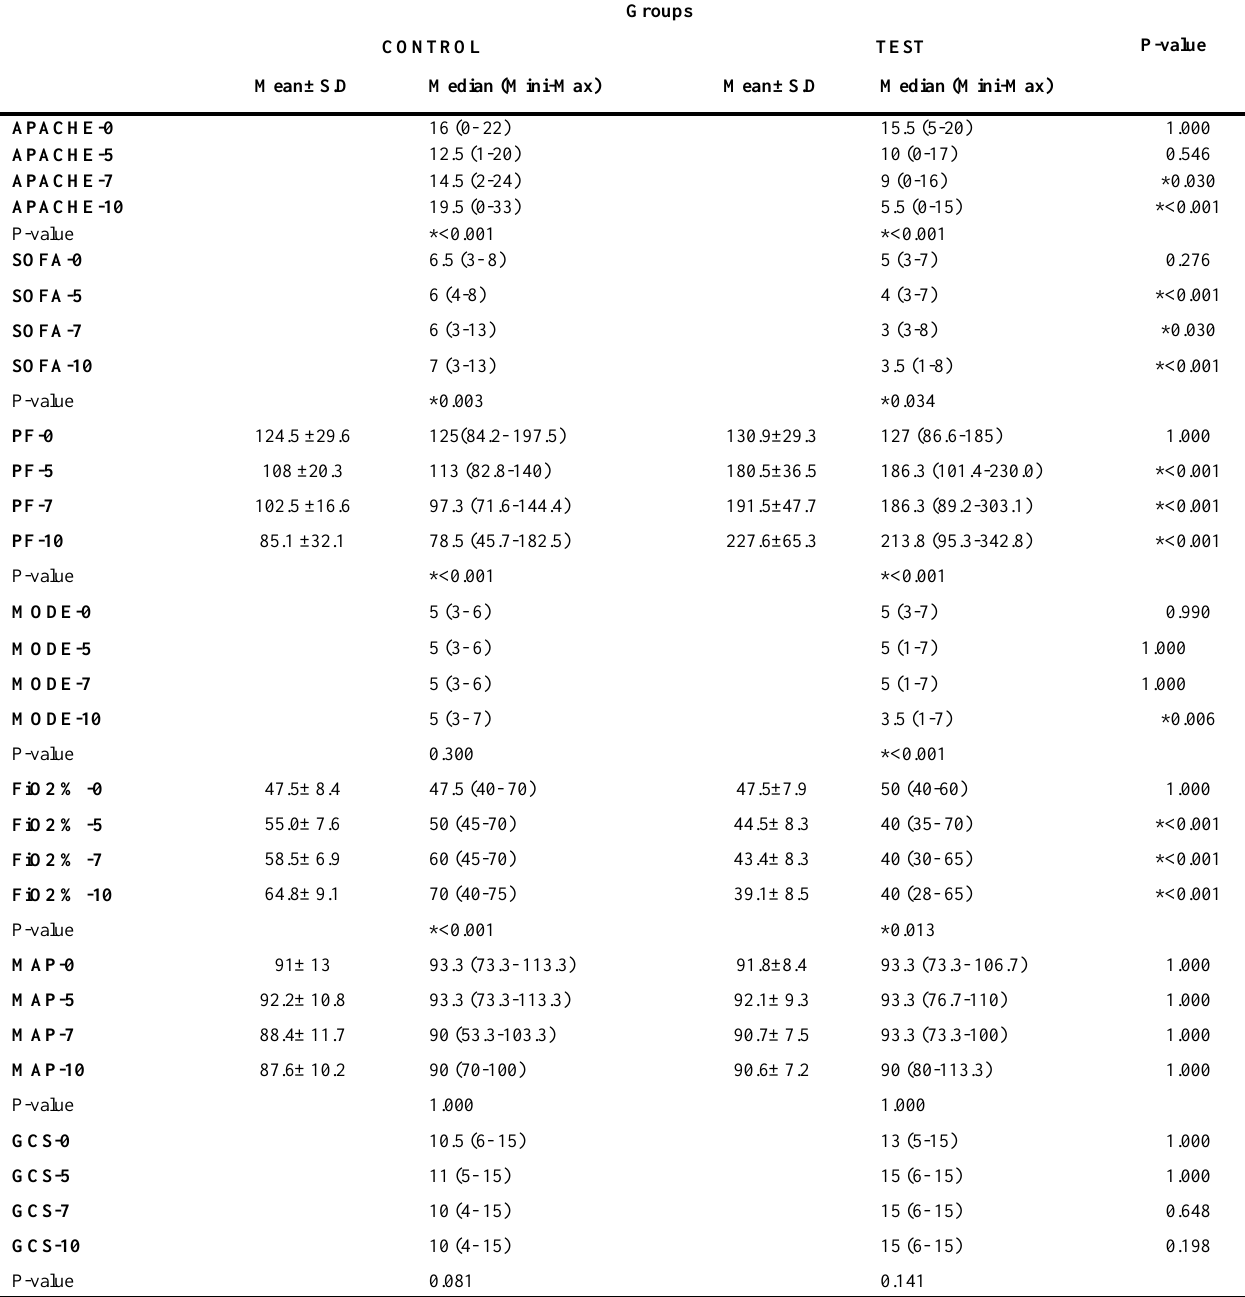
Table 2. Overtime assessment between the control and the test groups